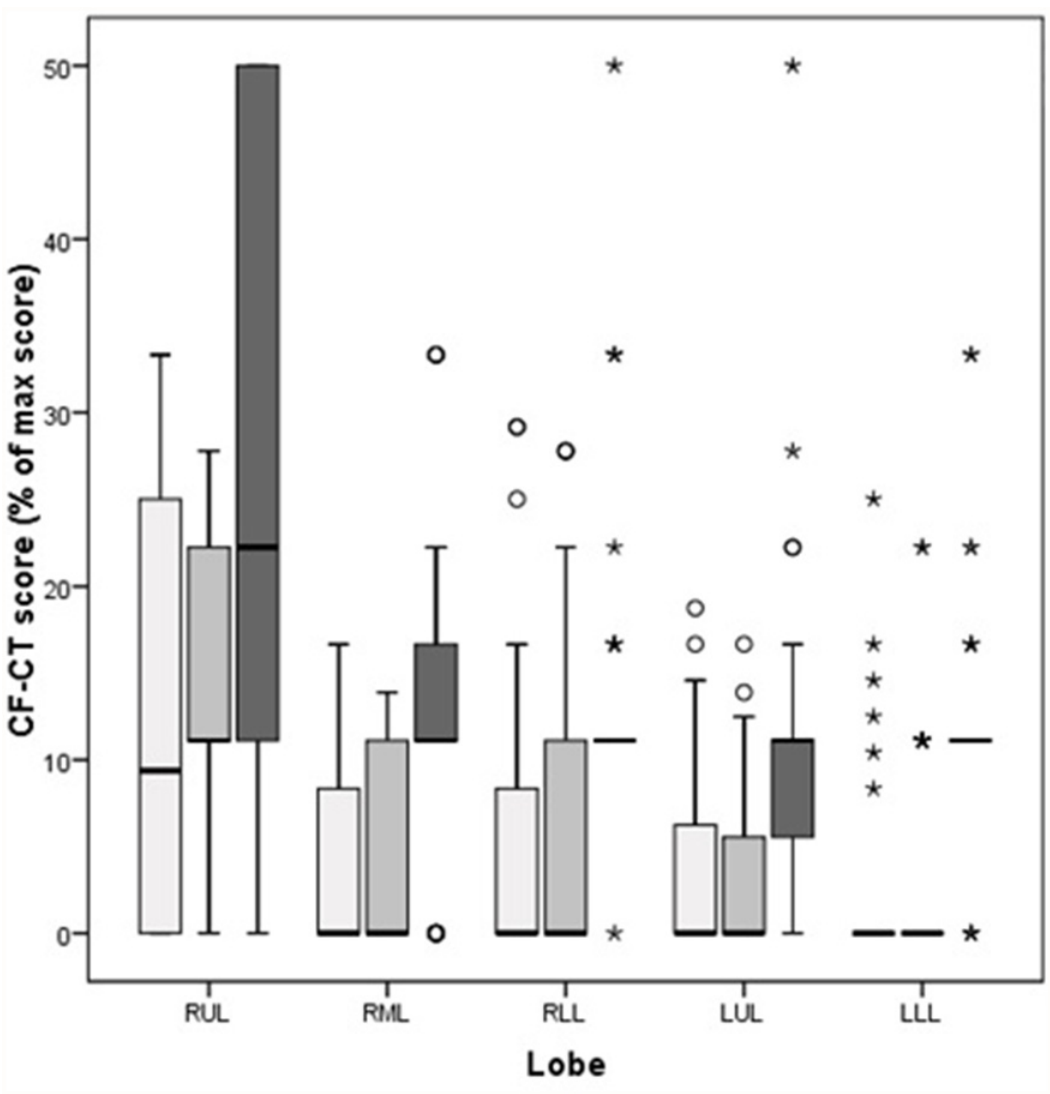
Fig 2. Comparison of CF-CT subscores per lobe. Comparison of CF-CT subscores per lobe, presented as % of max CF-CT score. Data are presented as median (range), unless otherwise indicated. White bars represent bronchiectasis score, light grey bars represent airway wall thickening score and dark grey bars represent air trapping score. RUL = right upper lobe (n = 22), RML = right middle lobe (n = 22), RLL = right lower lobe (n = 40), LUL = left upper lobe (n = 39), LLL = left lower lobe (n =